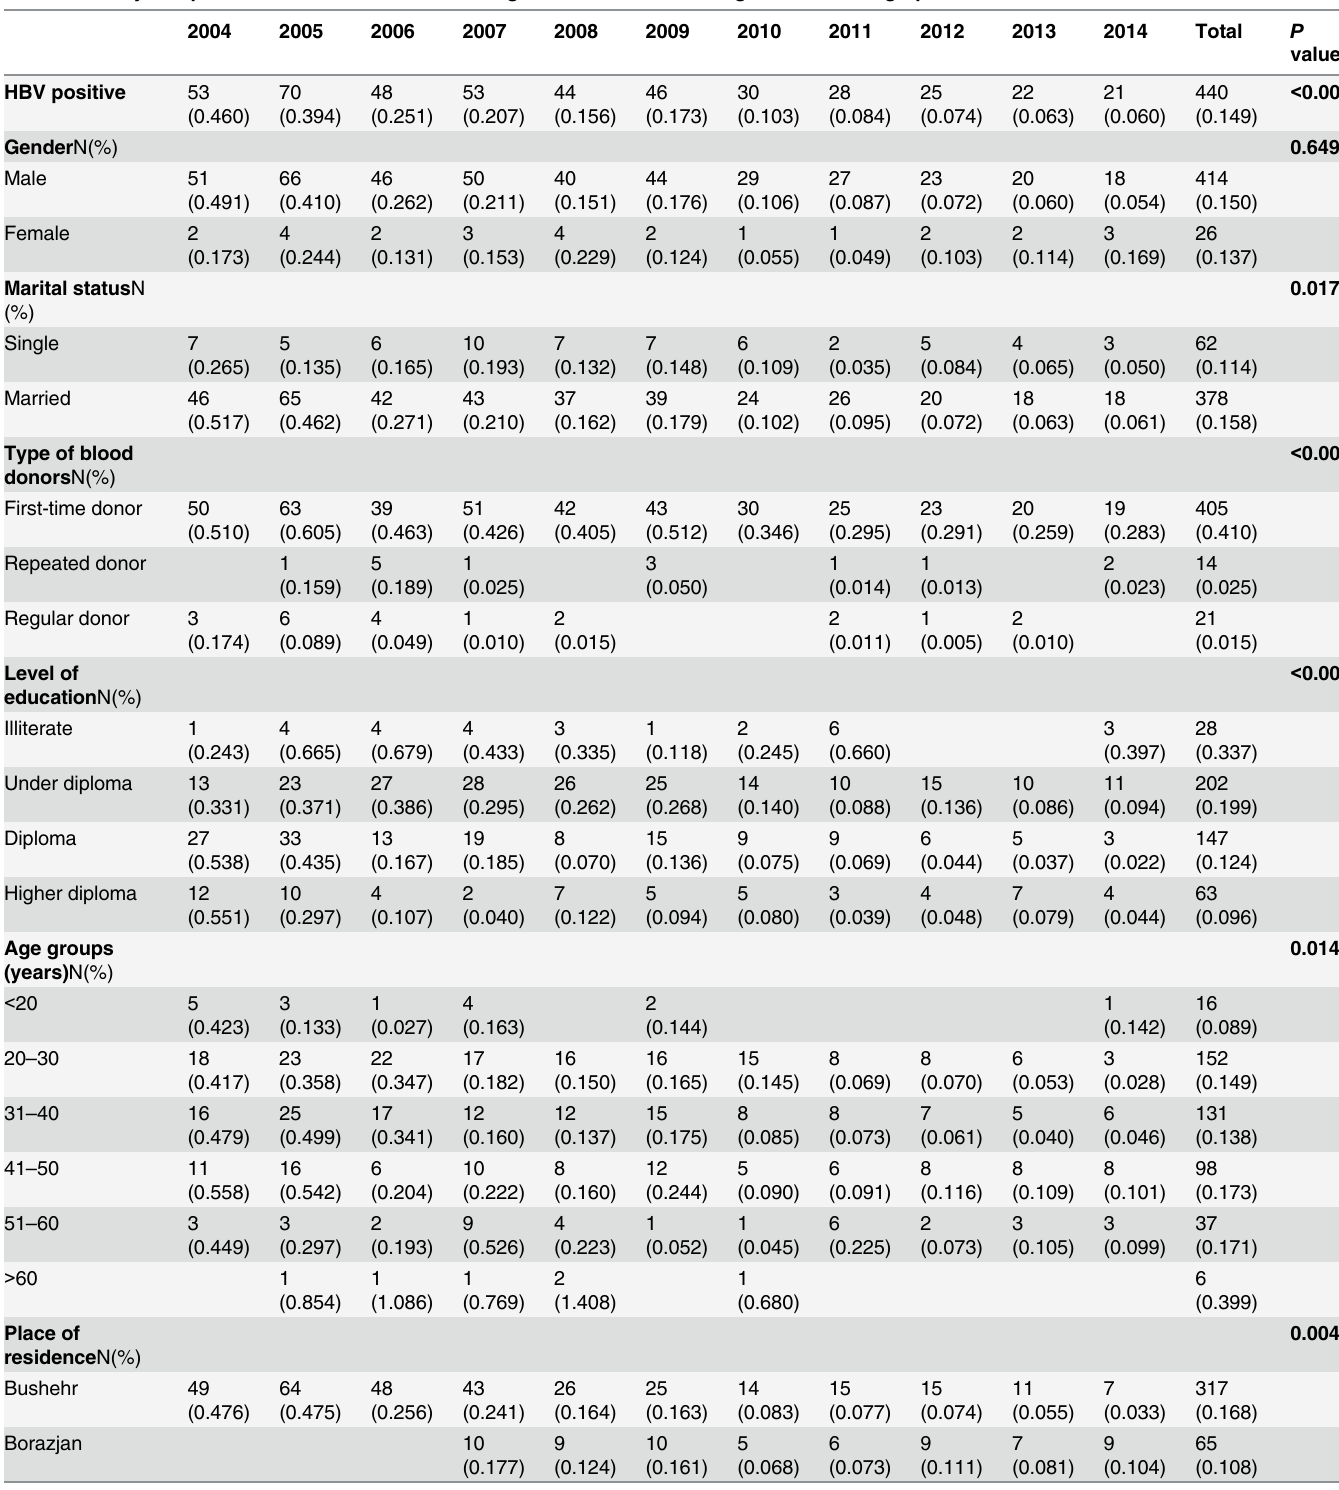
Table 3. Yearly seroprevalence of HBV infection among blood donors according to socio-demographic